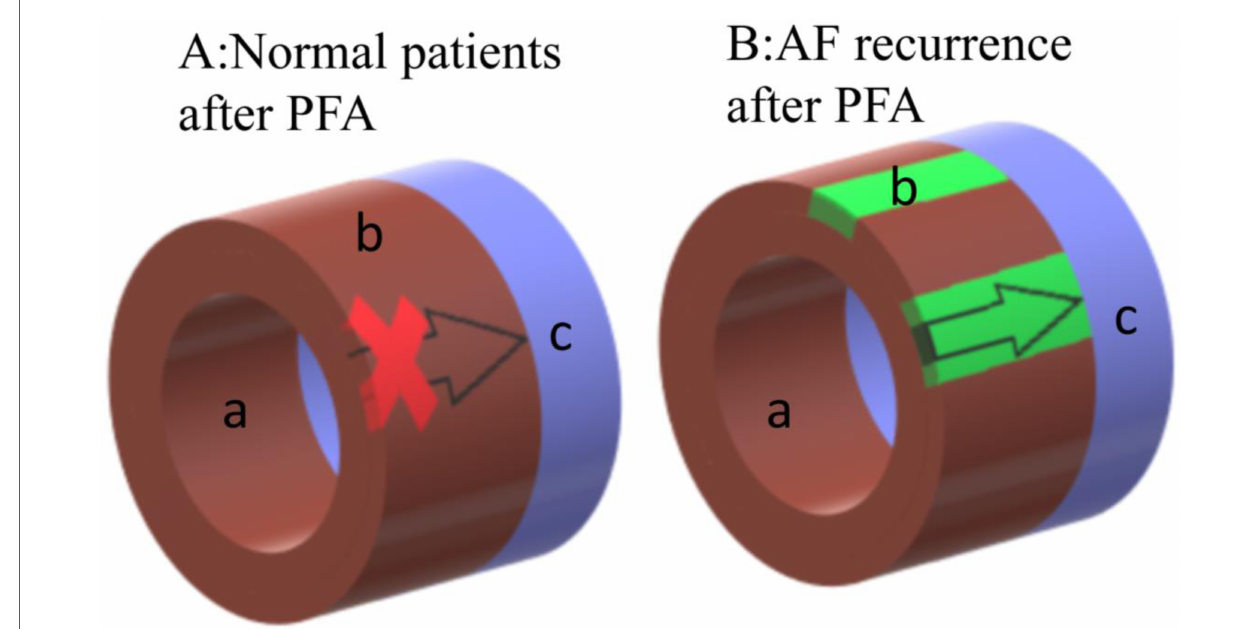
FIGURE 10 Schematic diagram of the ablation area after ablation.a indicates the endocardial membrane closing to the ablation electrode, which is the ablation central ablation area, and the myocardial cells in this area die instantly. b indicates the cardiomyocytes closing to the epicardium, which is the edge of ablation area, normal ablation also causes immediate death. However in some patients, this area that doesn ’ t die immediately undergoes gradual apoptosis. c indicates the pulmonary vein. Figure A represents the normal schematic diagram after PFA, the PV electrical signal is blocked. Figure B represents the schematic diagram of AF recurrence after PFA, as the direct death area doesn ’ t cover the epicardium due to improper operation or the patient ’ s own condition during the operation, the situation shown in Figure B will occur, and the PV electrial signal is not isolated, as well as AF will recur. In general, normal patients will directly go through stage A after PFA, while AF recurrence patients will exprience stage B fi rst and then type